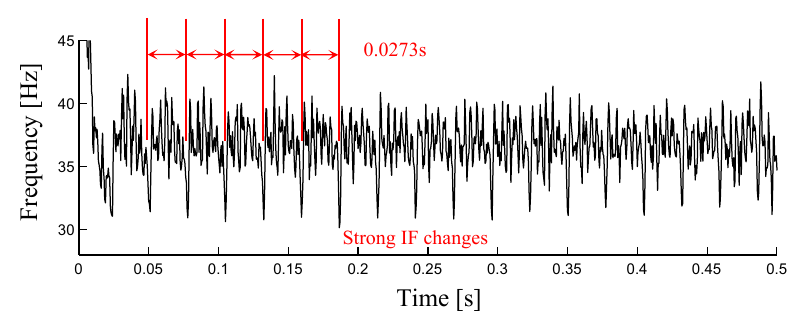
Figure 16. The zoom-in plot of the FFT spectrum.